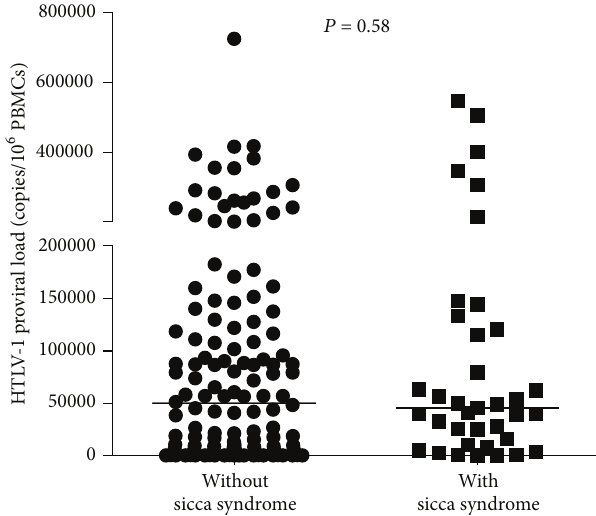
Figure 2: HTLV-1 proviral load of HTLV-1 infected individuals with and without sicca syndrome. Proviral load was quantified by real-time TaqMan PCR method and the normalized value of the proviral load was calculated as the ratio of (HTLV-1 DNA average copy number/albumin DNA average copy number) × 2 × 10 6 and expressed as the number of HTLV-1 copies per 10 6